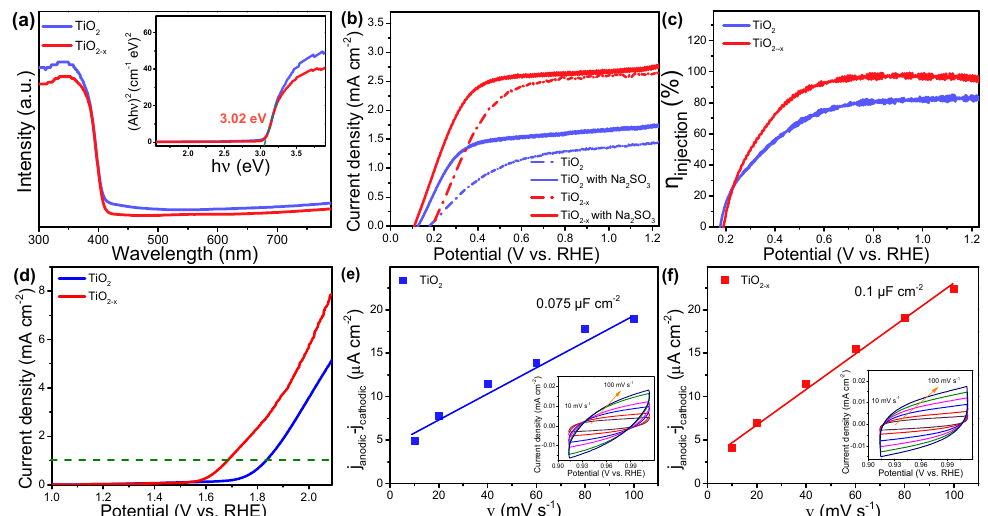
Figure 4. ( a ) UV-vis diffuse reflectance spectra; the inset shows the Tauc plots of TiO 2 and TiO 2-x ; ( b ) LSV curves of TiO 2 and TiO 2-x photoanodes in the presence of sacrifice agents (0.5 M Na 2 SO 3 ); ( c ) charge injection efficiencies; ( d ) LSV curves in dark of TiO 2 and TiO 2-x ; relative electrochemical surface areas (ECSA) of ( e ) TiO 2 and ( f ) TiO 2-x ; linear relationship between the capacitive current and scan rate; the insets show the CV curves of TiO 2 and TiO 2-x under different scan rates, respectively.